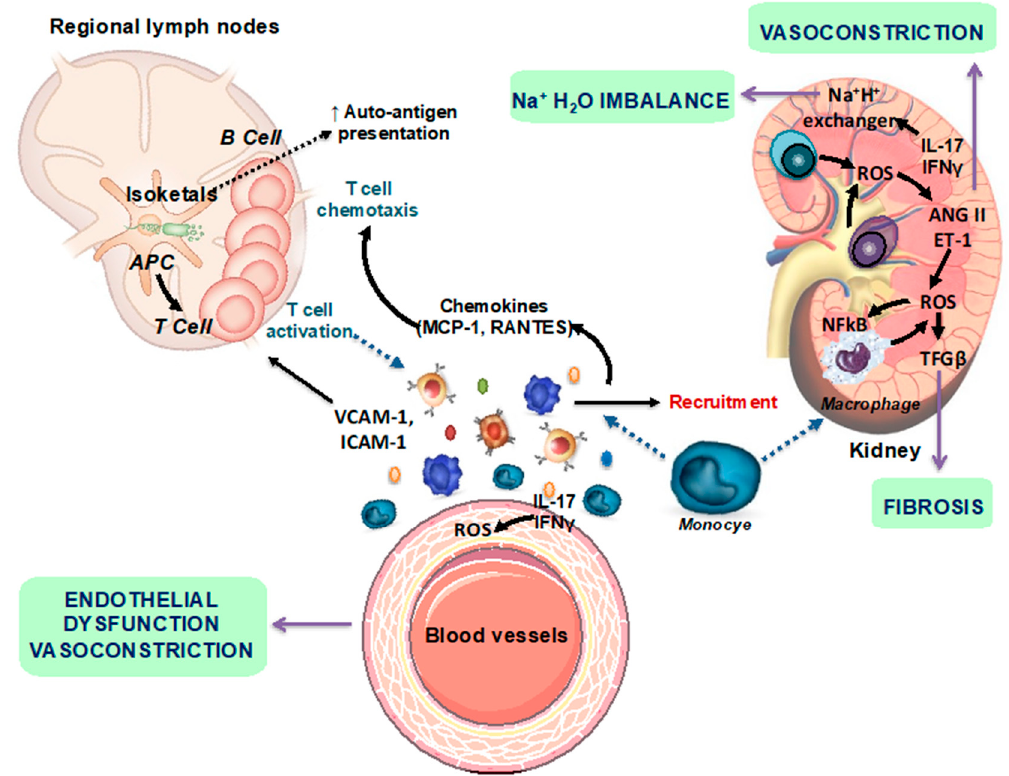
Figure 1. Scheme representing the autoimmune mechanisms involved in the development of renal and vascular changes. AngII, angiotensin II; ET-1, endothelin-1; IFN- γ , interferon- γ ; IL-17a, interleukin 17a; NF-kB, nuclear factor-kB; ROS, reactive oxygen species; Treg, T regulatory (modified from [10]).